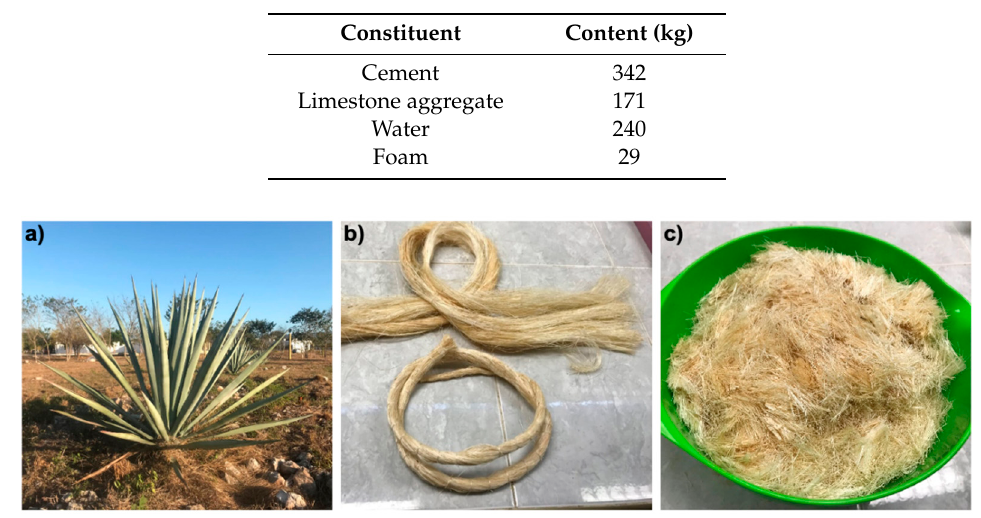
Table 1. Constituent proportions of foamed concrete for 1 m 3 .